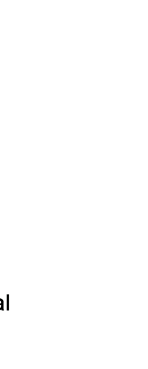
Figure 6. Genetic diagram of Bad-mediated radiosensitization of zebrafish neural tissue. IR activates the pro-apoptotic activity of Bad in a pathway that is either downstream of or parallel to p53 (dotted lines indicate that it is unclear whether this step occurs in a p53- dependent or –independent manner). Bad and Puma are dependent upon each other to promote IR-induced apoptosis. However, based on Bad’s established role as a sensitizer BH3-only protein and Puma’s reported role as an activator BH3-only protein, Bad likely functions upstream of Puma to induce IR-mediated apoptosis through the mitochondrial